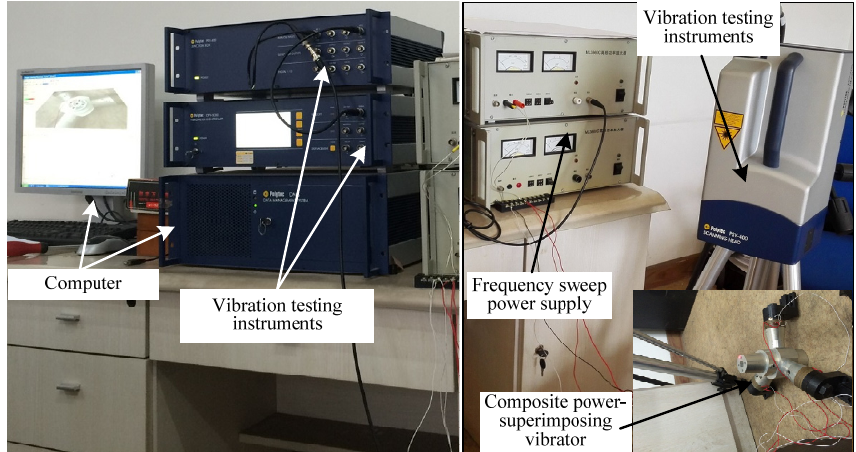
Figure 14. Vibration measurement system. Appl. Sci. 2016 , 6 , 32